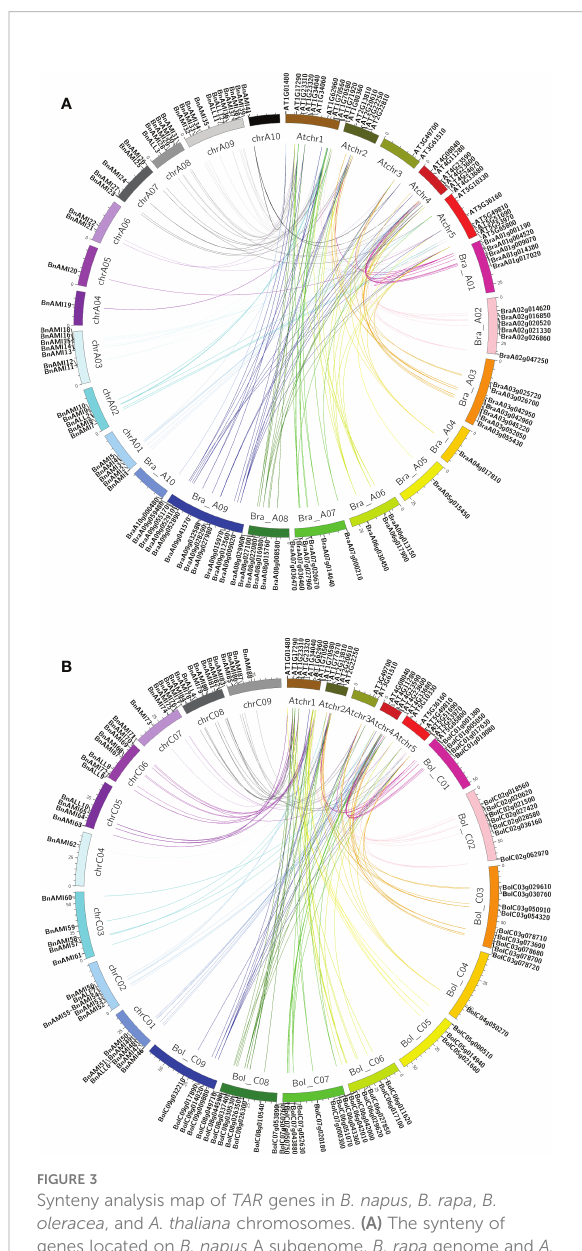
FIGURE 3 Synteny analysis map of TAR genes in B. napus , B. rapa , B. oleracea , and A. thaliana chromosomes. (A) The synteny of genes located on B. napus A subgenome, B. rapa genome and A. thaliana genome. (B) The synteny of genes located on B. napus C subgenome, B. oleracea genome and A. thaliana